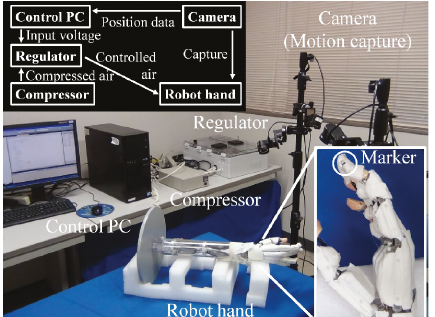
Figure 3: System overview. Two insets show the system fl ow (top-left) and the position of the marker captured by the cameras in an enlarged view of the robot hand (bottom-right). The marker is set to the tip of the musculoskeletal robot (the index fi nger). The input voltage from the control PC is converted to the controlled pressures by the regulators, and the musculoskeletal robot is driven by the pressures supplied to each muscle of the robot. The position of the tip is measured using the marker captured by the cameras and is saved to the